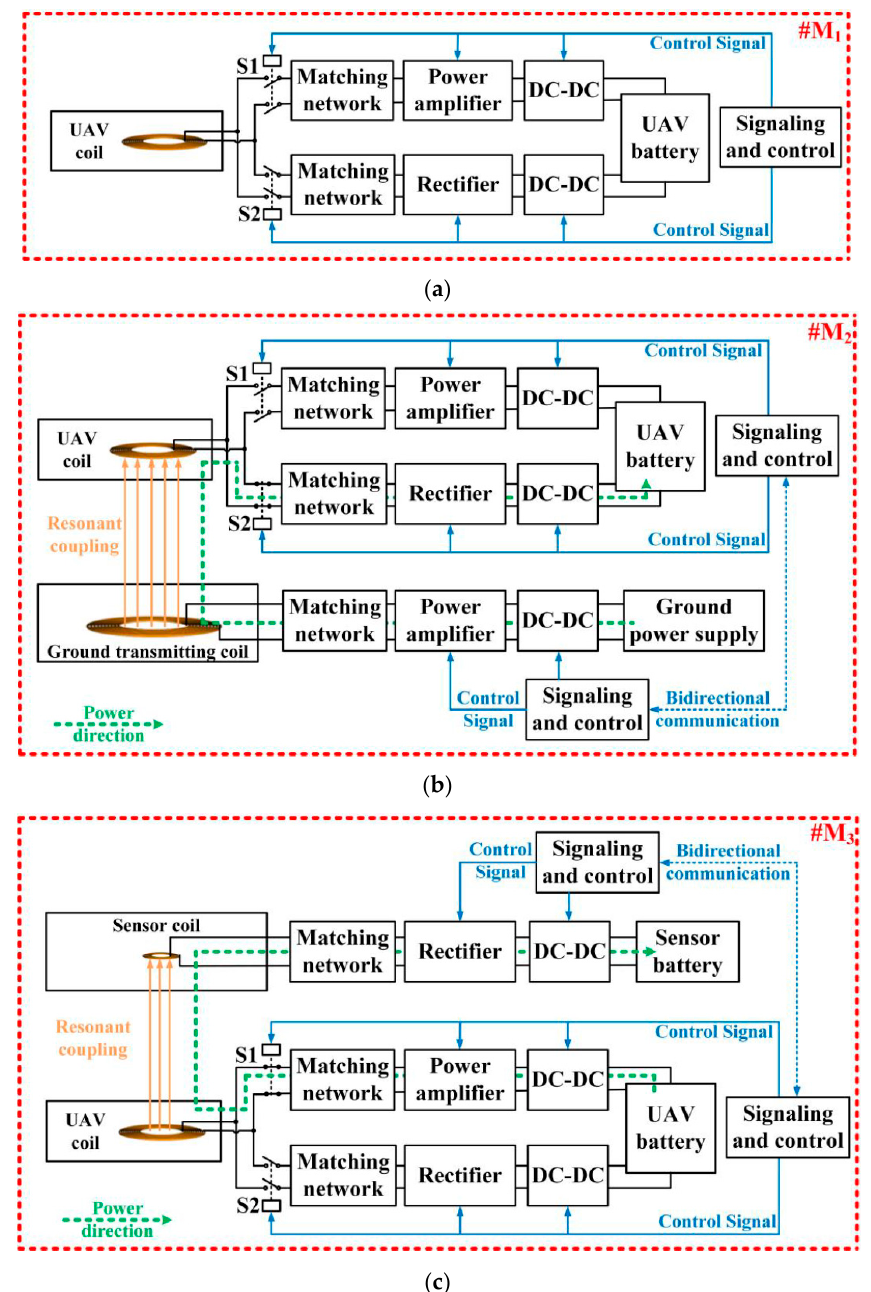
Figure 2. Unmanned aerial vehicle (UAV) bidirectional wireless charging system in working modes ( a ) #M1, ( b ) #M2, and ( c ) #M3.